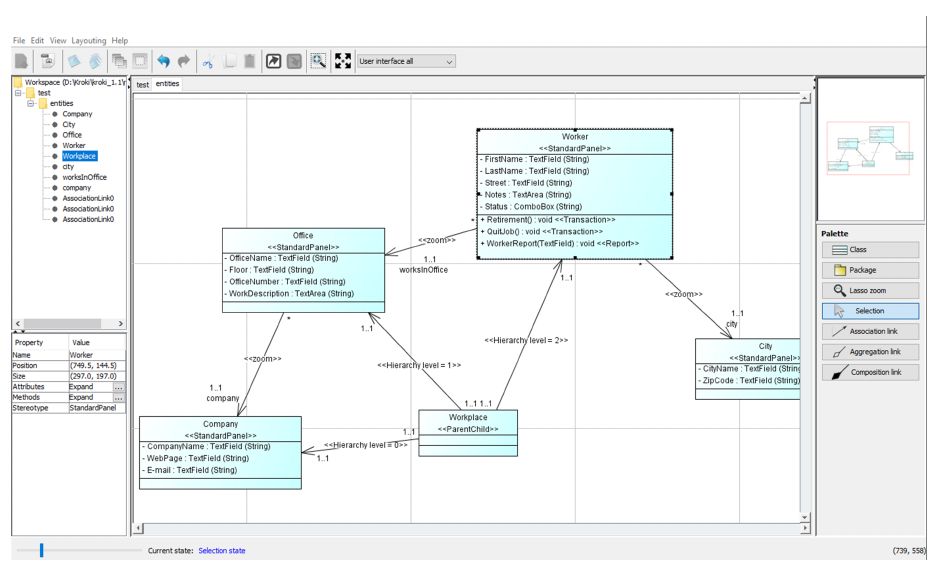
Figure 3. Kroki’s lightweight UML editor.